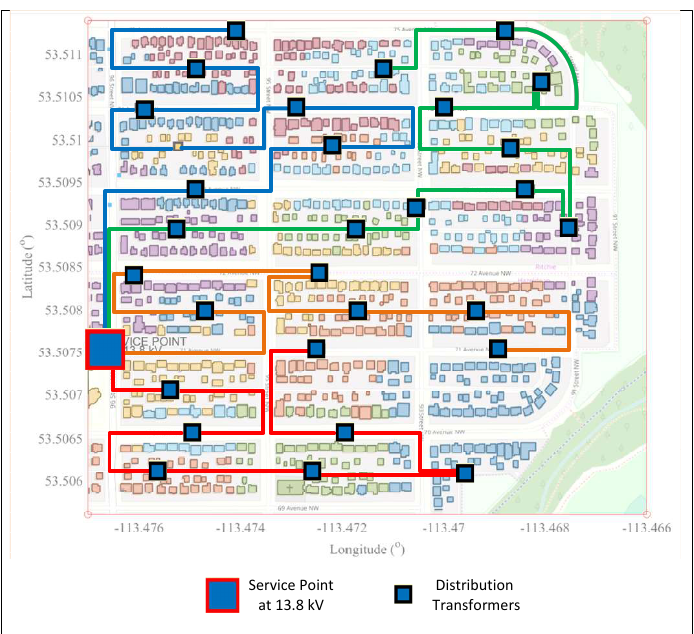
Figure 1. Radial distribution network on georeferential